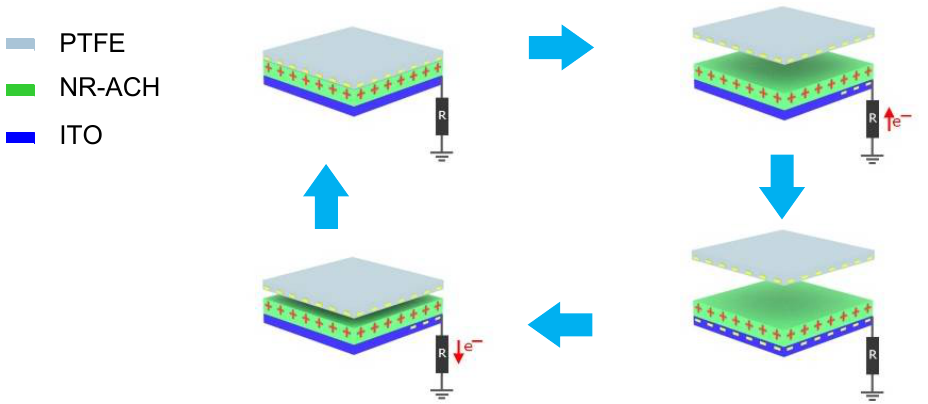
Figure 2. Working mechanism of the NR-ACH TENG.